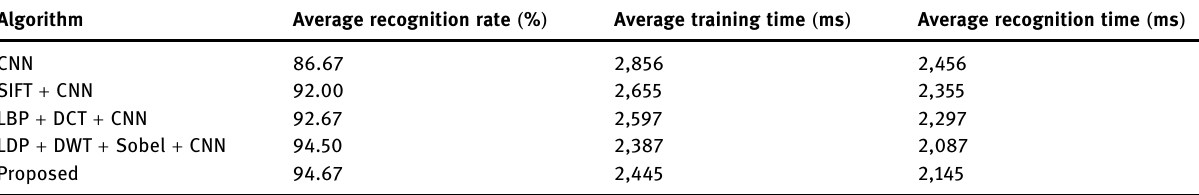
Table 5: Time test results of di ff erent algorithms